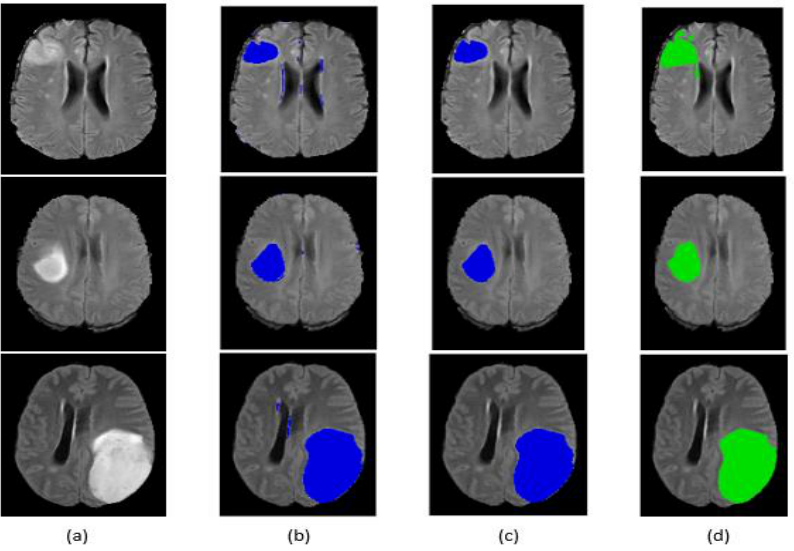
Figure 10. Segmentation result of our method on some BraTS 2017 LGG images: ( a ) original image, ( b ) segmentation before post-processing, ( c ) segmentation after post-processing, ( d ) ground truth.